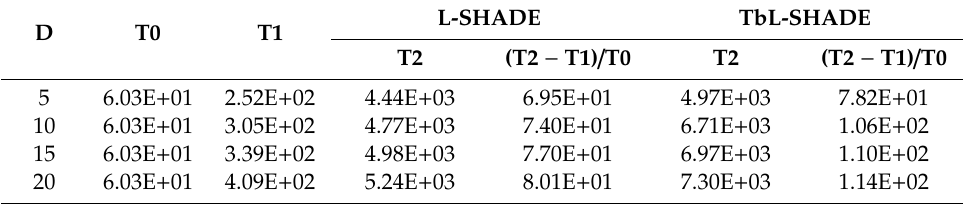
Table 2. Time complexity specified by CEC2020 technical document—L-SHADE vs. TbL-SHADE.